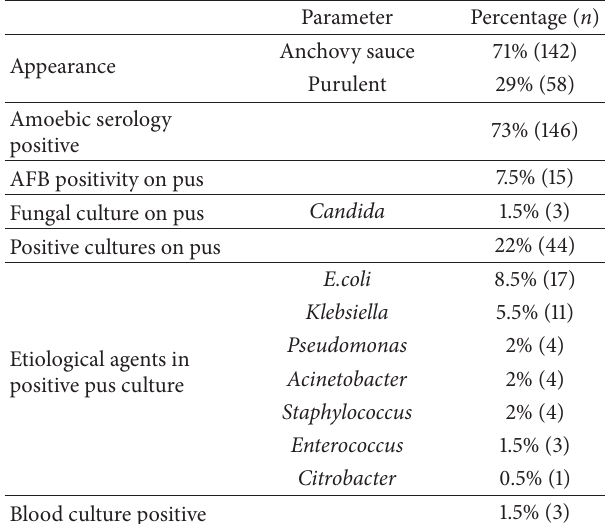
Table 4: Management outcome: majority of patients were managed by needle aspiration. Surgical intervention was done in 8 patients, all for rupture, out of which 5 died.